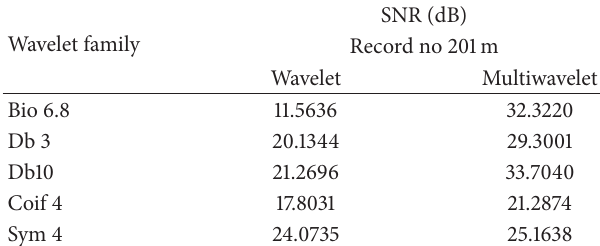
Table 3: Performance comparison of wavelet and multiwavelet for record 114 m.